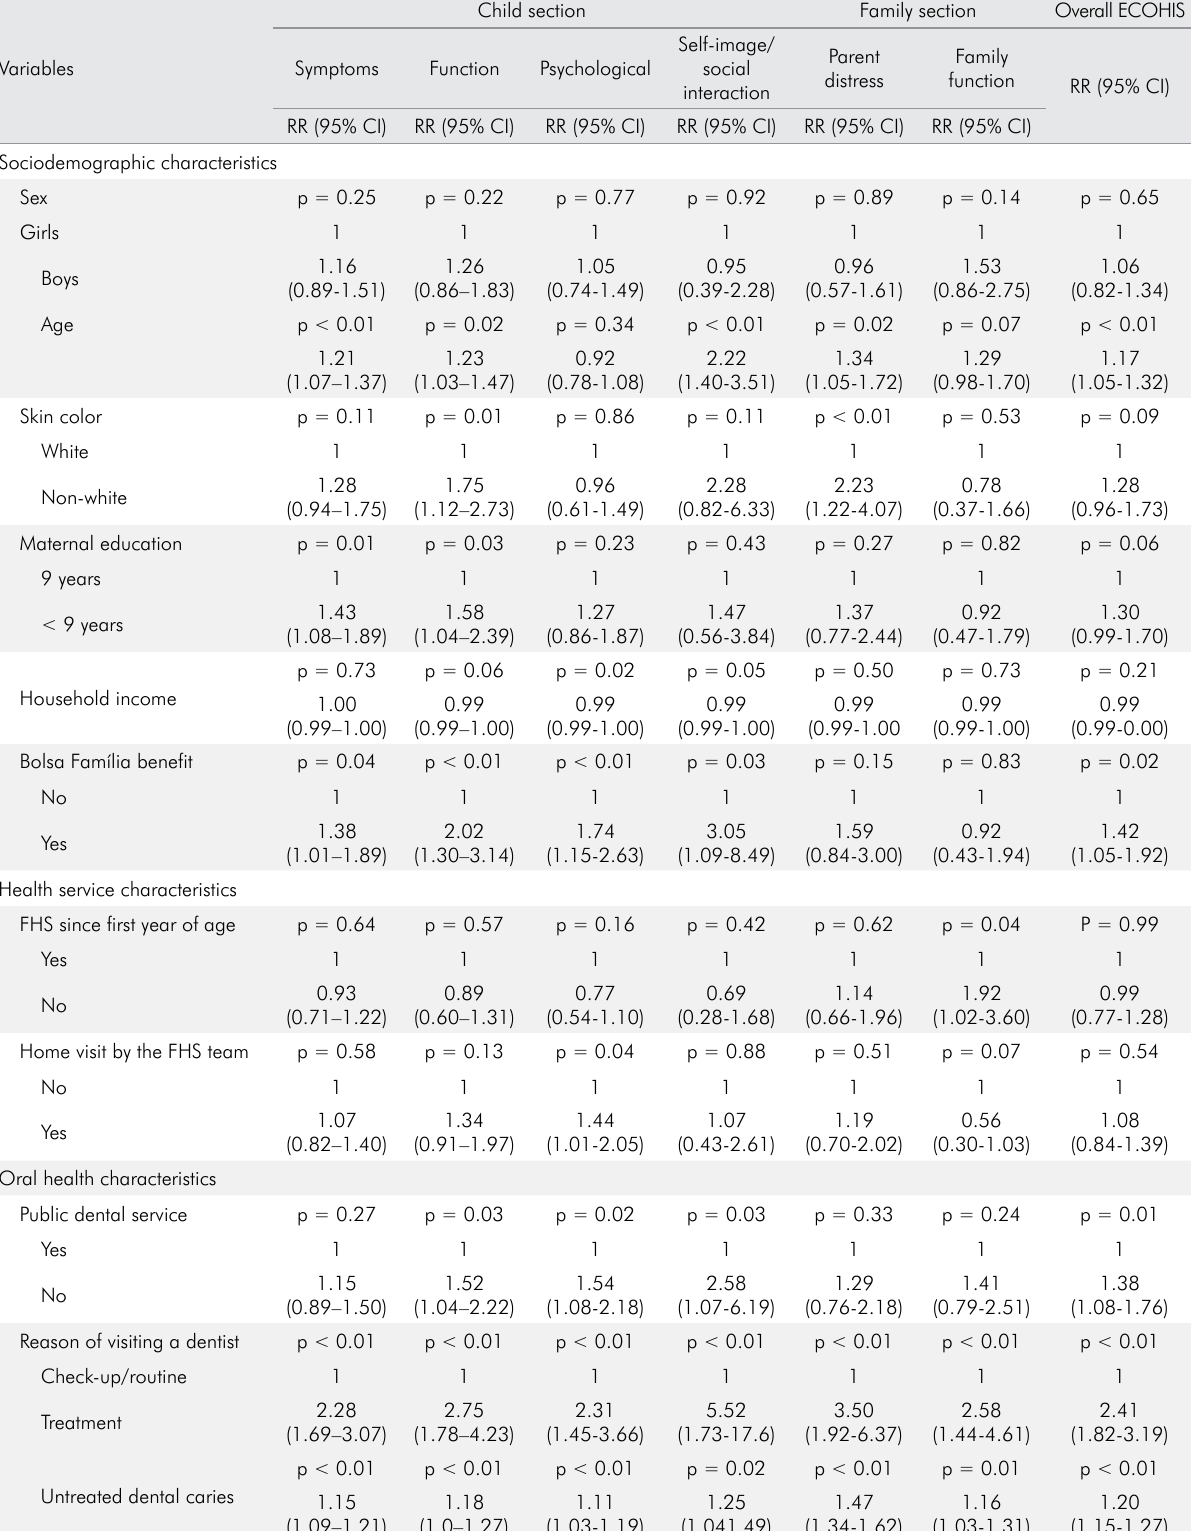
Table 3. Unadjusted association between independent variables and overall and domain-specific ECOHIS scores at baseline (T1) and 2-year follow-up (T2), determined using multilevel Poisson